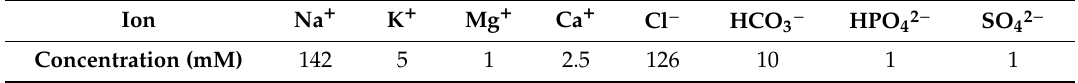
Table 2. Ionic composition of simulated body fluid